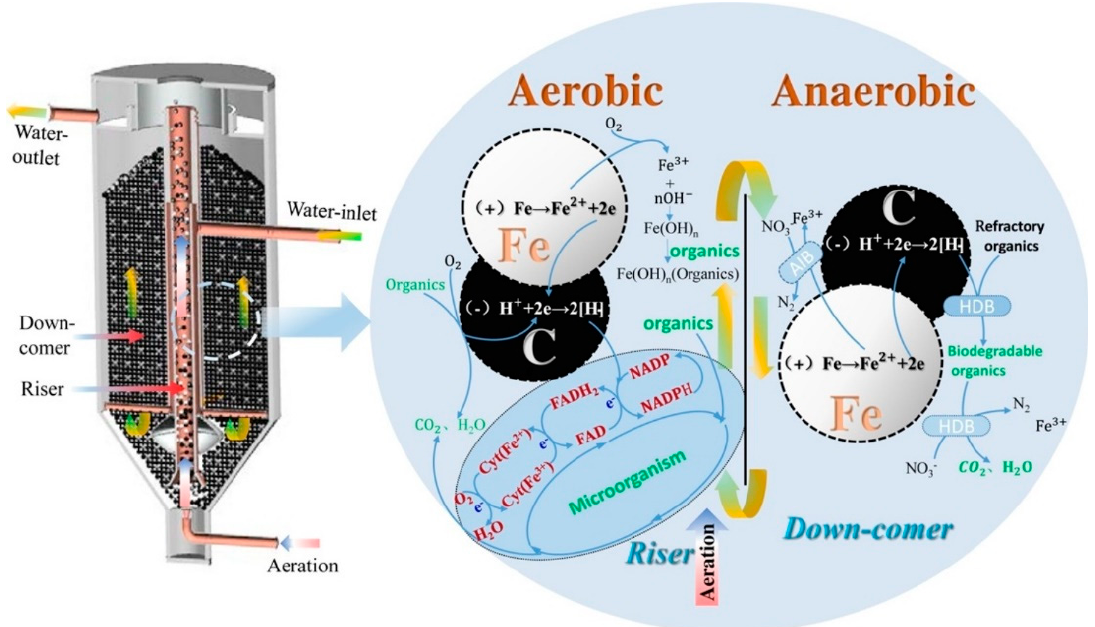
Figure 9. Combination of microelectrolysis and membrane bioreactor (MBR). Reprinted with permission from ref. [190]. Copyright 2020 Elsevier Ltd.